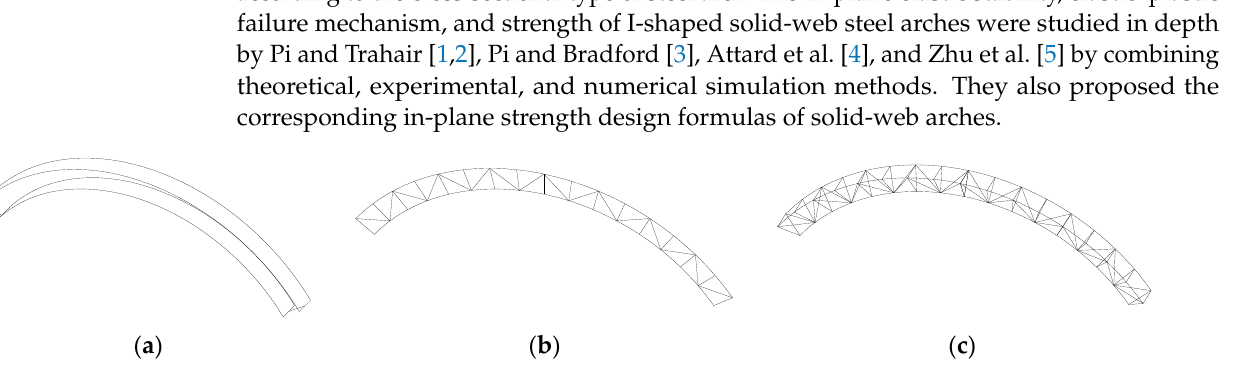
Figure 2. Cross-sectional types of steel arches: ( a ) solid-web arch; ( b ) plane truss arch; ( c ) spatial truss arch.